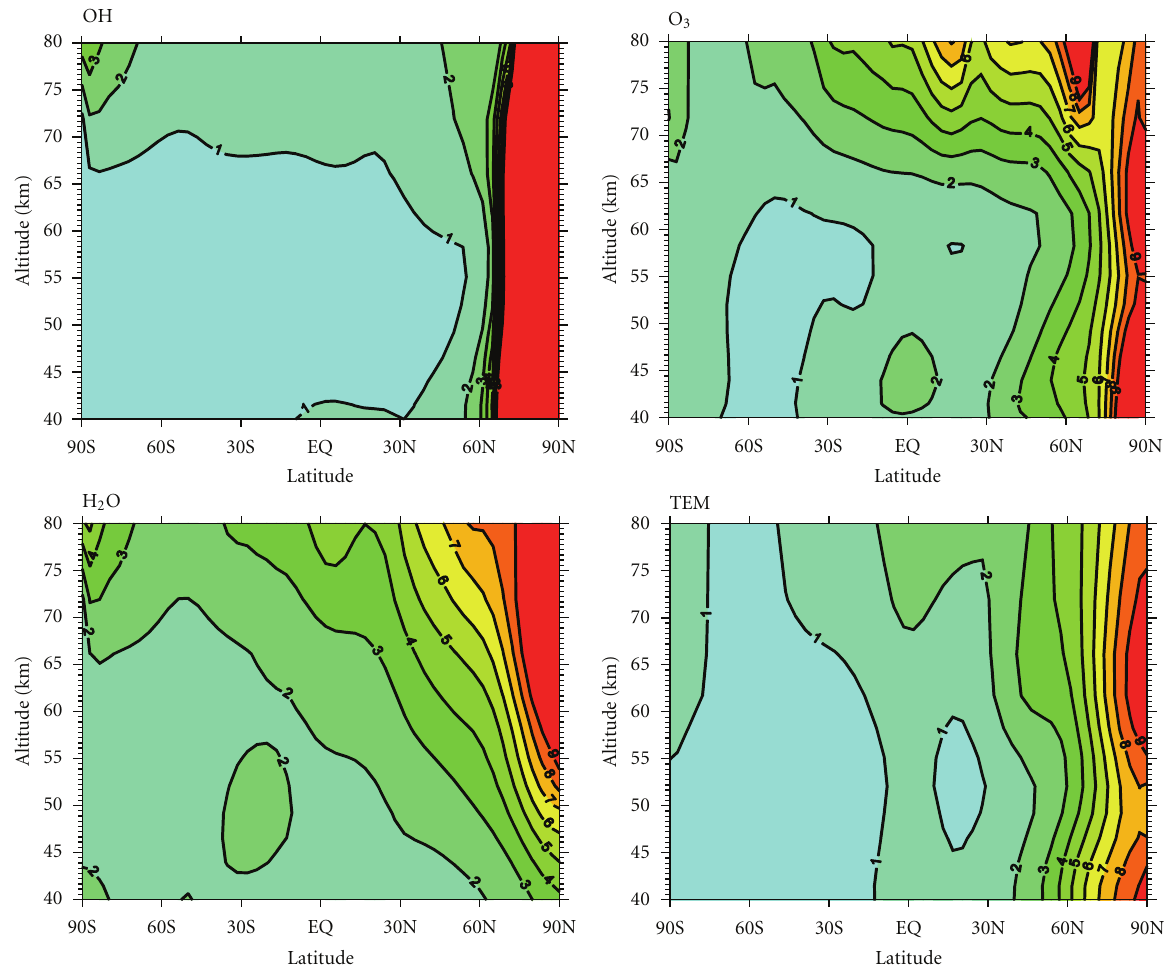
Figure 3: Mean absolute deviation among the ensemble members averaged over 30-day interval. Mean absolute deviation for species is shown in percent relative to the mean mixing ratio. Mean absolute deviation for the temperature is given in